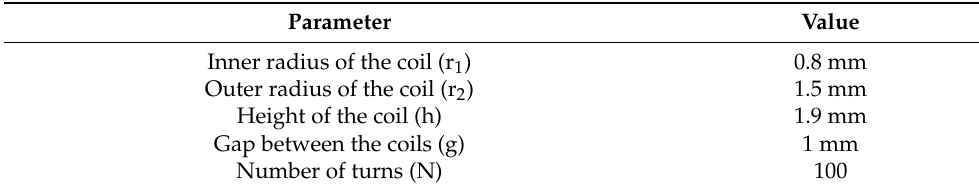
Figure 2. Physical picture of the sensor. Table 1. Coil